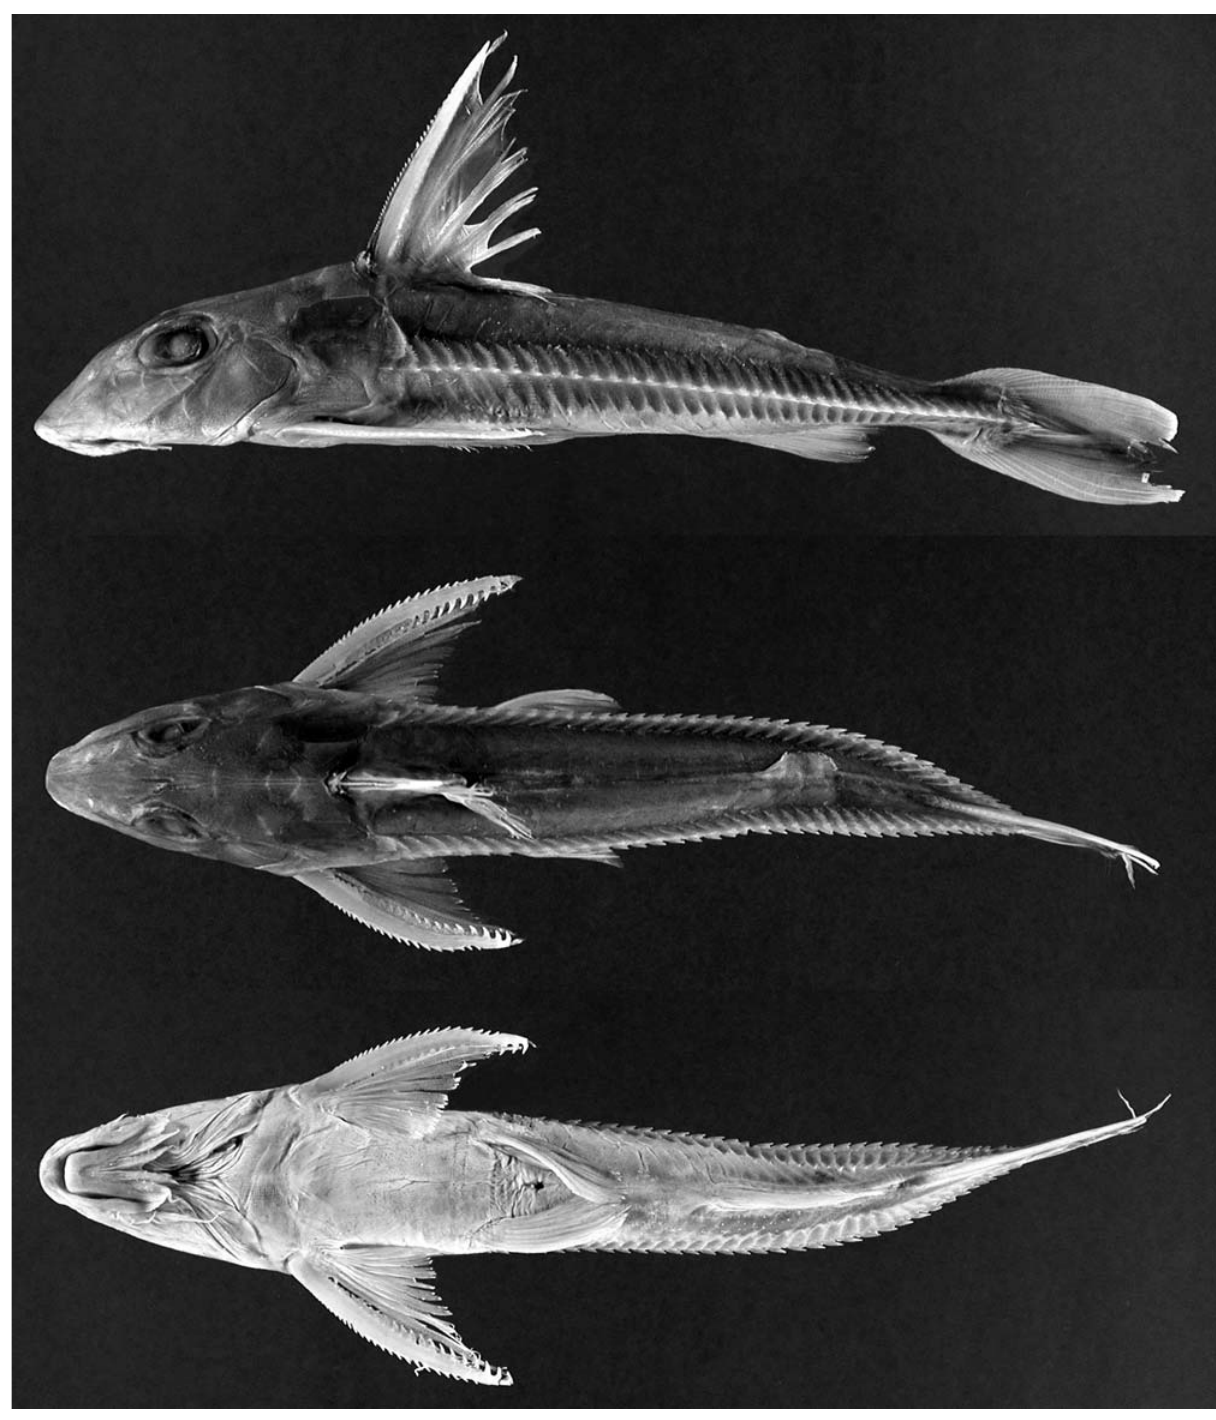
Fig. 14. Leptodoras linnelli , BMNH 1911.10.31:73-74 (SL 162.2 mm, paratype), Potaro river (Essequibo dr.) Tumatumari,